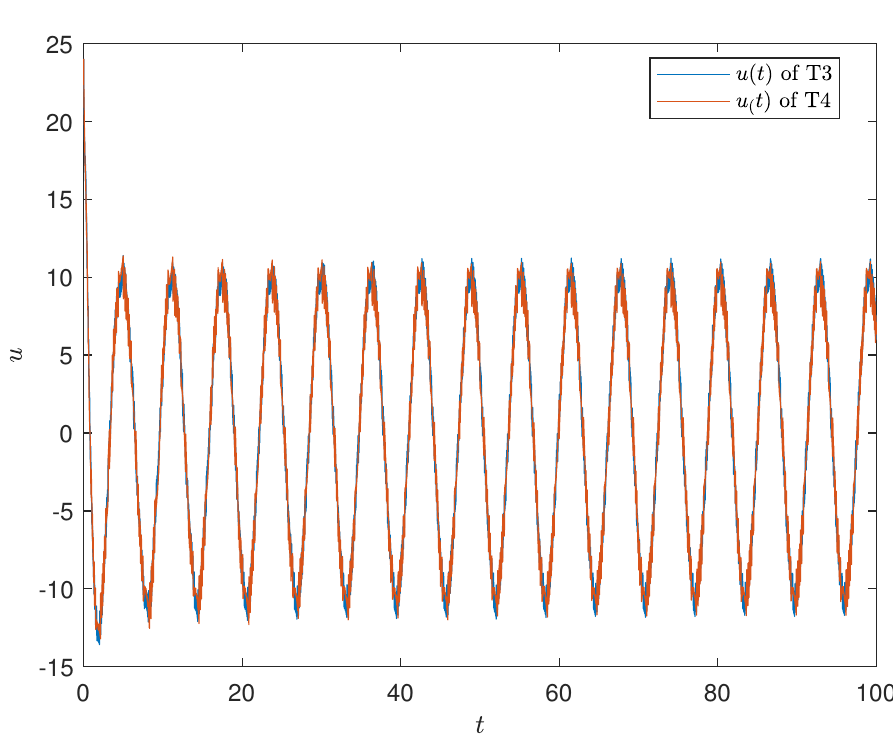
Figure 9. The errors z 1 of Testings T3–T4.